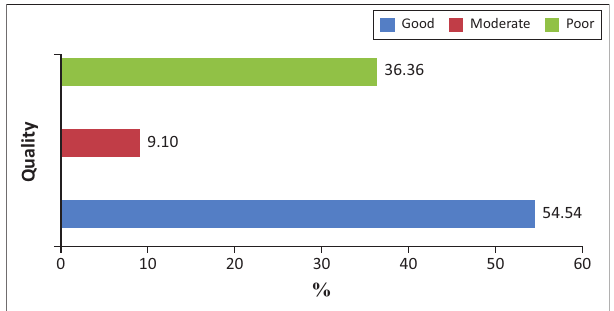
FIG URE 2: Quality of delivered